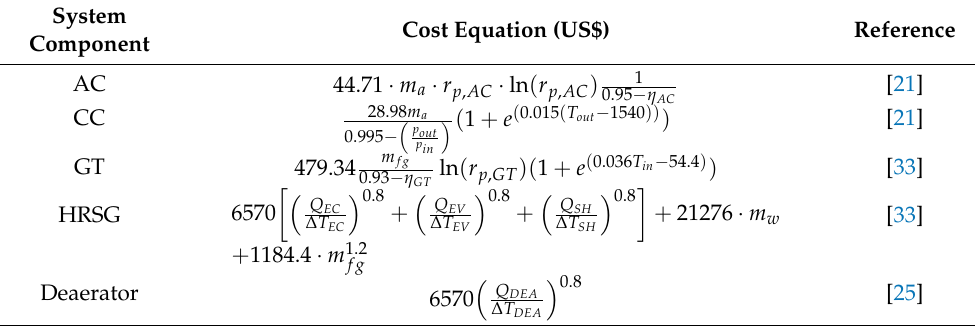
Table A3. Capital investment for different system